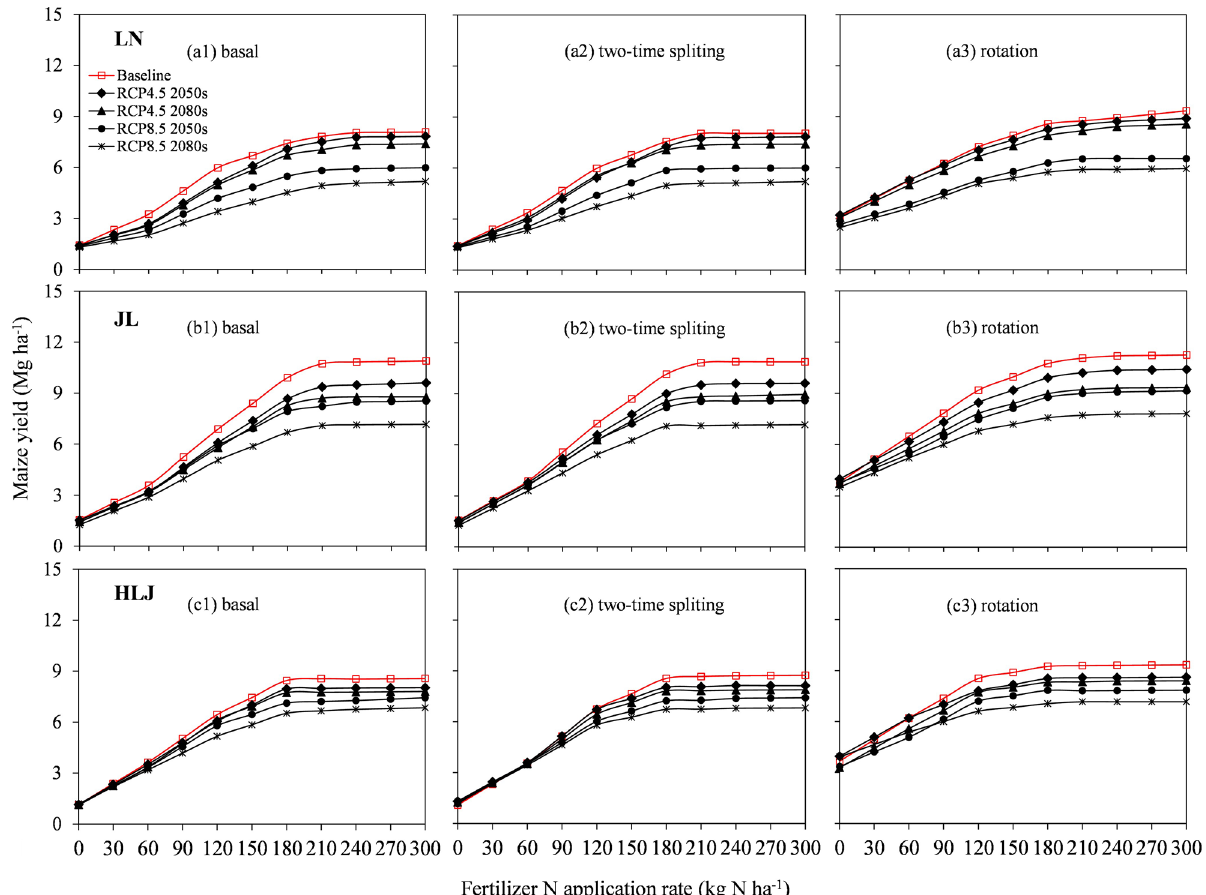
Figure 2. Responses of maize yields to nitrogen (N) application rate as basal ( a1 , b1 , c1 ), as two-time splitting ( a2 , b2 , c2 ) for maize monoculture and as basal for maize-soybean rotation ( a3 , b3 , c3 ) under climate change scenario BC1 (BCC-CSM1.1) at Liaoning (LN), Jilin (JL) and Heilongjiang (HLJ) provinces in Northeast